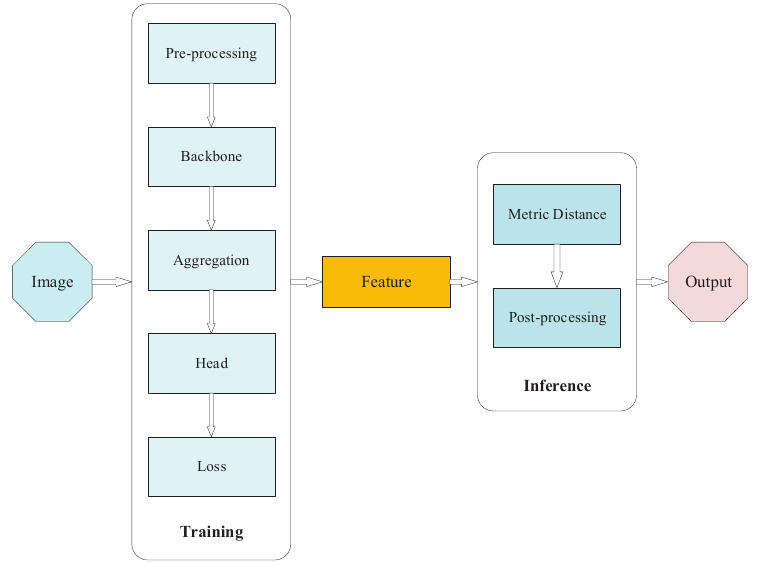
Figure 1. A framework of the vehicle Re-ID